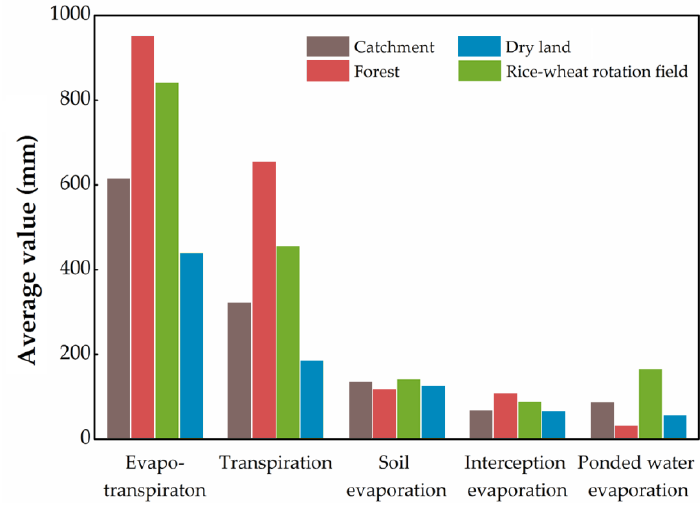
Figure 8. A comparison of mean annual evapotranspiration and its components at land use type and whole catchment scales (2000–2013) for the Qinhuai River Basin.